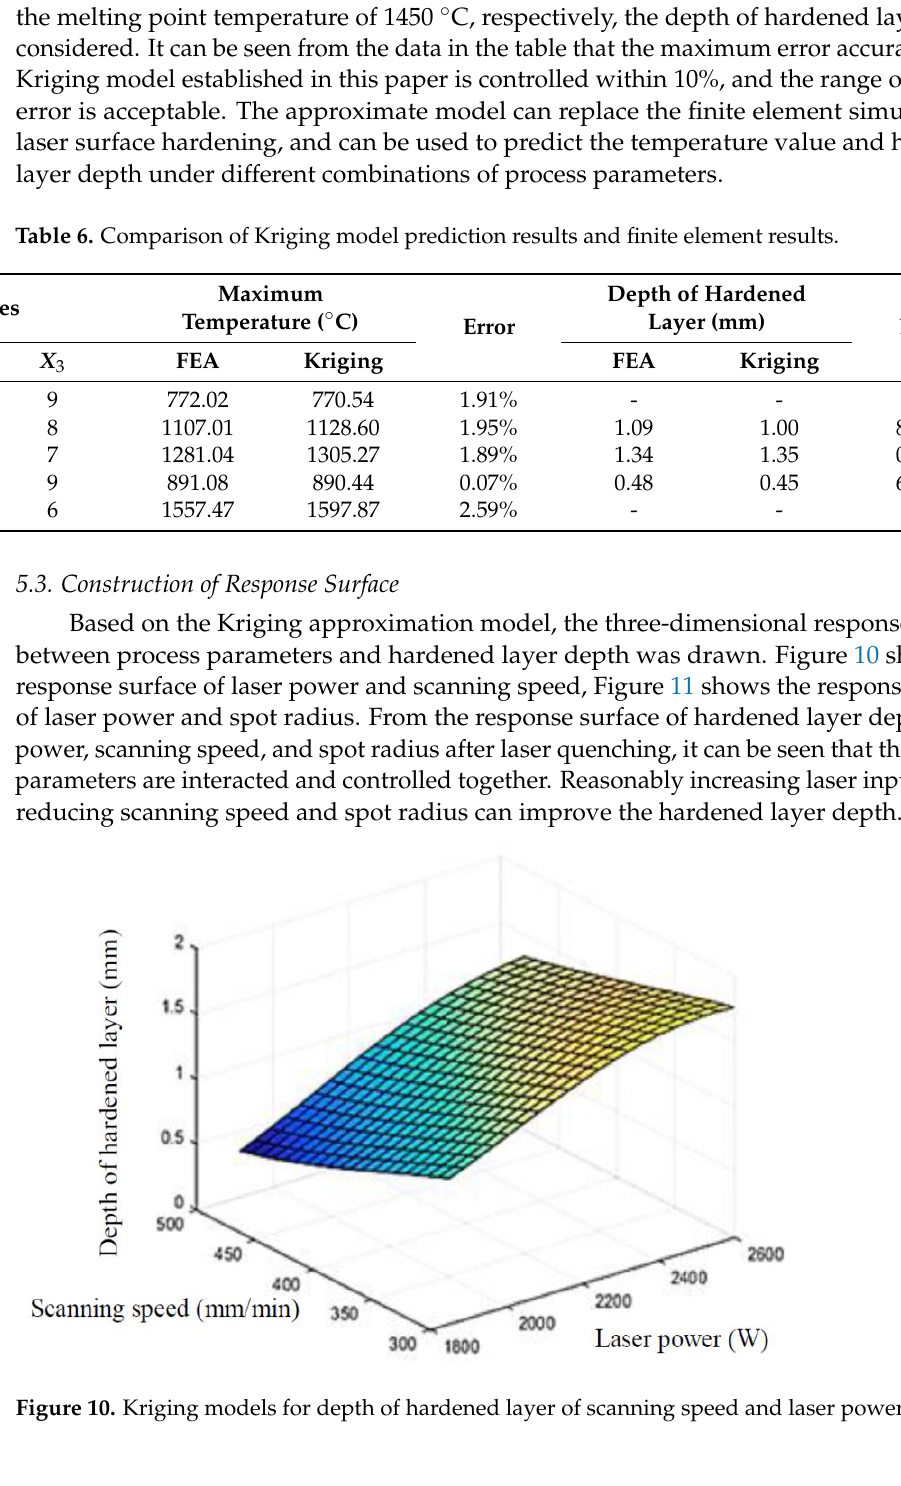
Figure 11. Kriging models for depth of hardened layer of laser power and spot radius. 6. Conclusions (1)